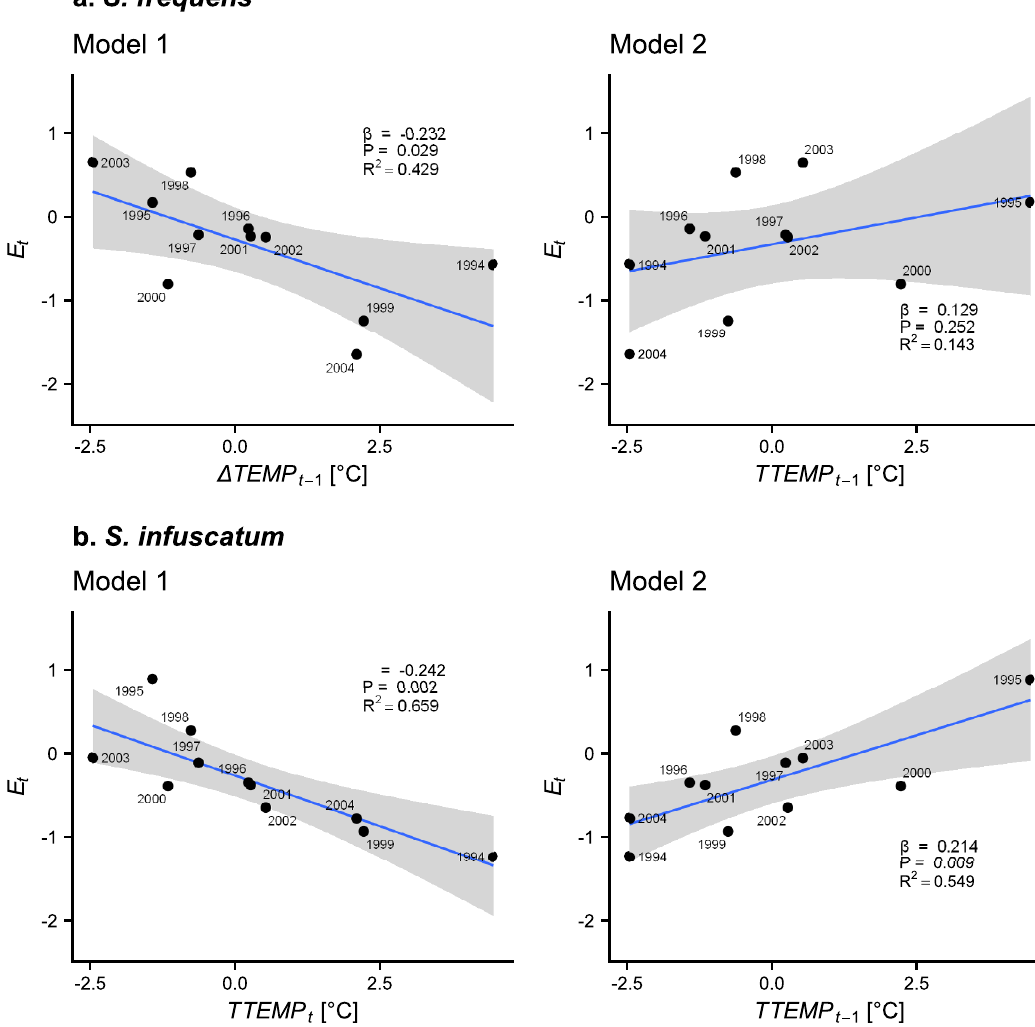
Figure 2. Association between ∆ TEMP in the 90th percentile values of daily mean temperature during July– August (∆ TEMP t ) and population growth rate (λ t ) of ( a ) Sympetrum frequens and ( b ) S. infuscatum in Toyama Prefecture from 1993 to 2004. The shaded zone represents the 95% confidence interval. The labels indicate year t . The results of regression analyses are shown in each